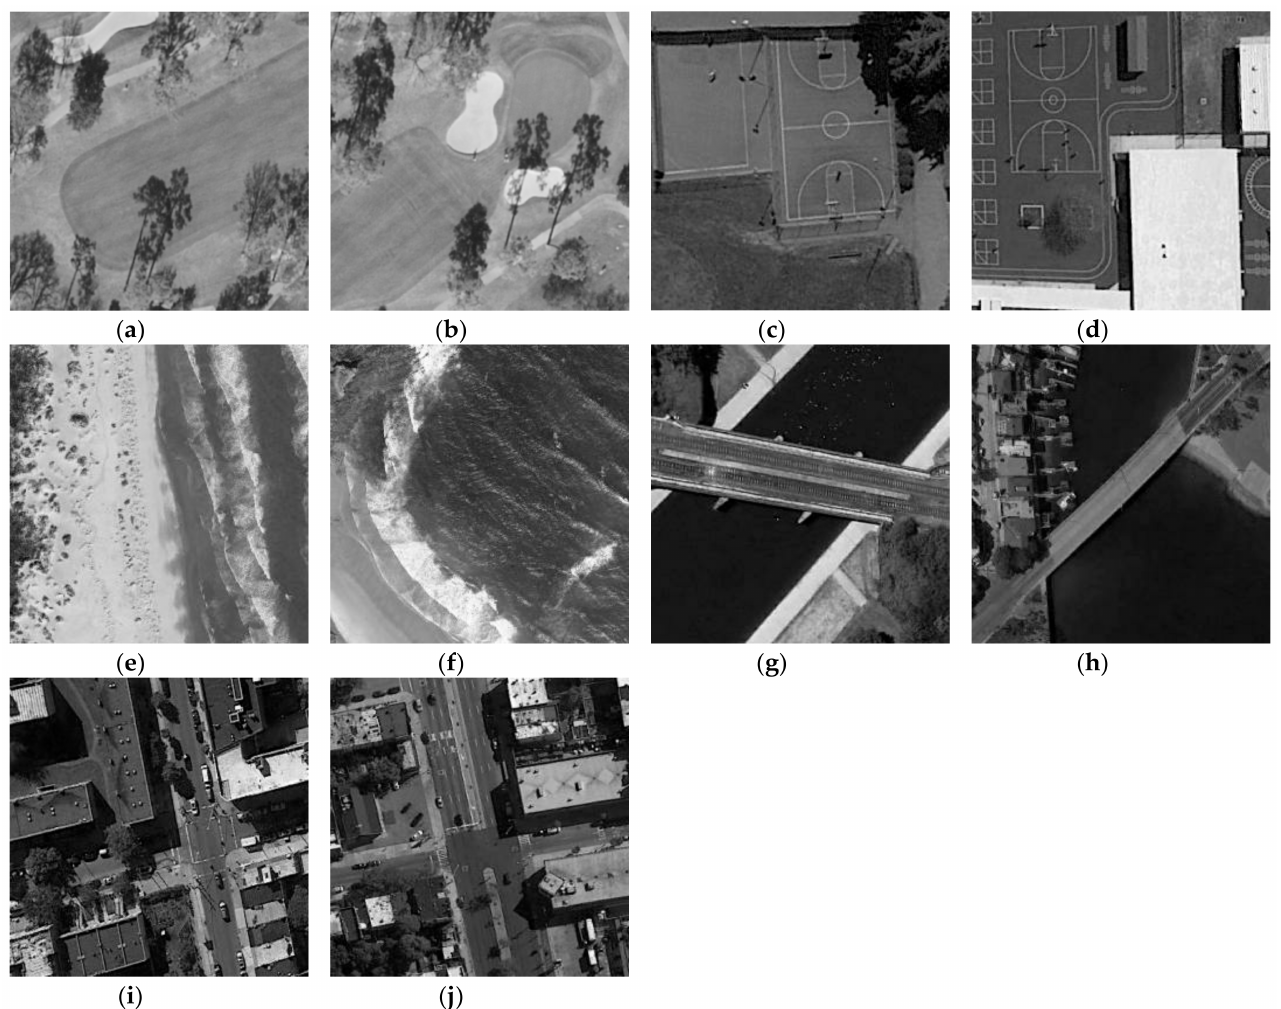
Figure 5. The 10 testing images marked in order from ( a ) to ( j ). ( a , b ) are golf course, ( c , d ) are basketball court, ( e , f ) are beach, ( g , h ) are bridge, ( i , j ) are medium